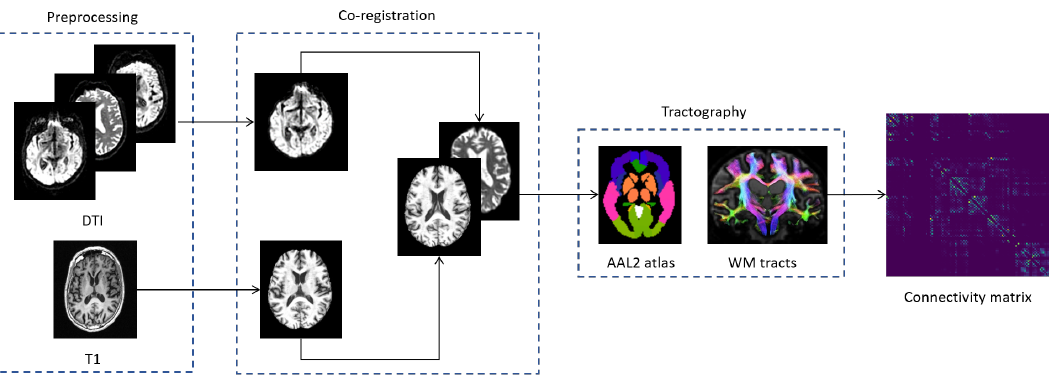
Figure 1. Image processing pipeline adapted from